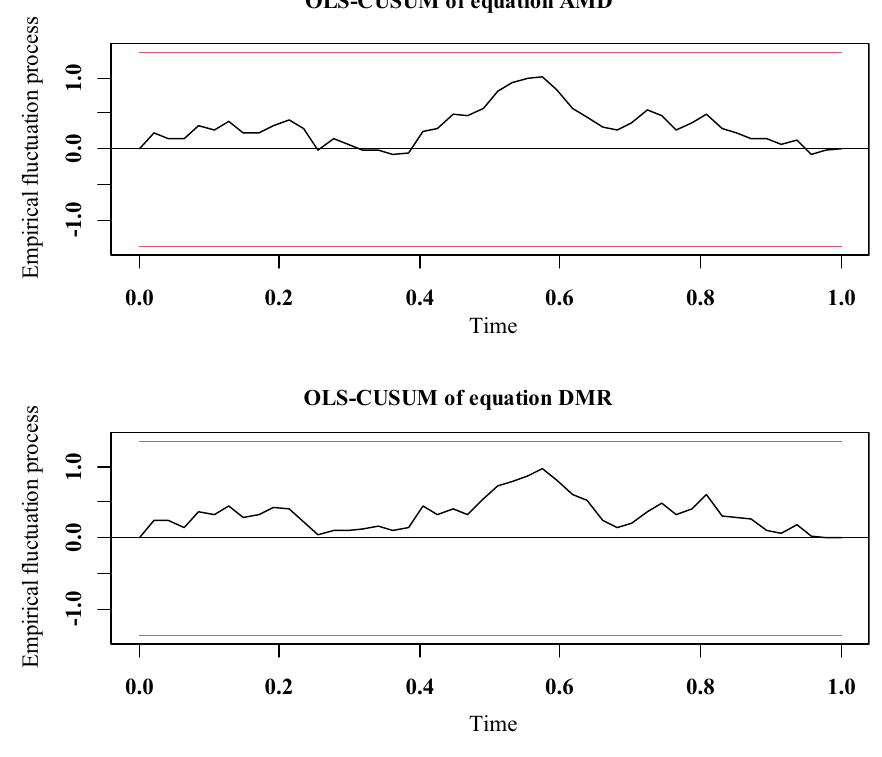
OLS-CUSUM of equation